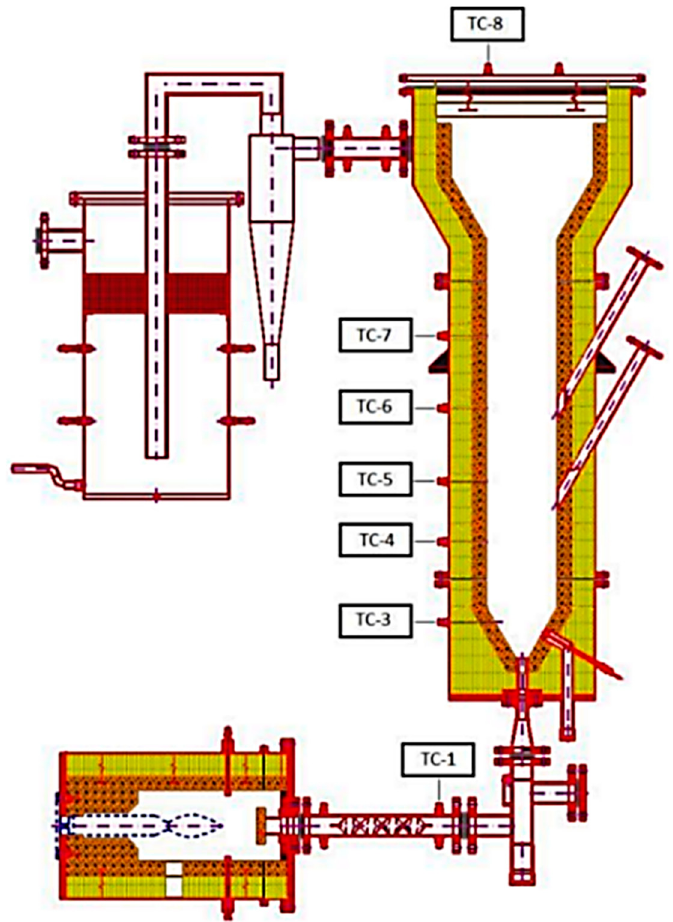
Figure 2. Thermocouples in the gasifier reactor. TC-1 is a static mixer, TC-3 and TC-4 are the base of the reactor, TC-5, TC-6, and TC-7 are mid sections of the reactor, and TC-8 is the reactor top.